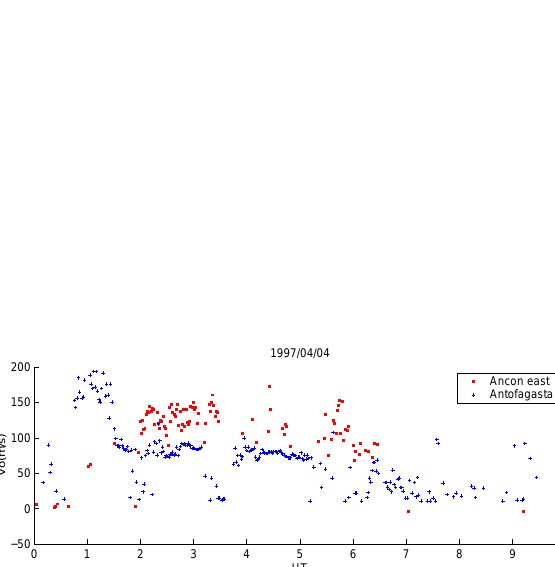
Fig. 9. (e) Same as Fig. 9a for 5 April 1997.